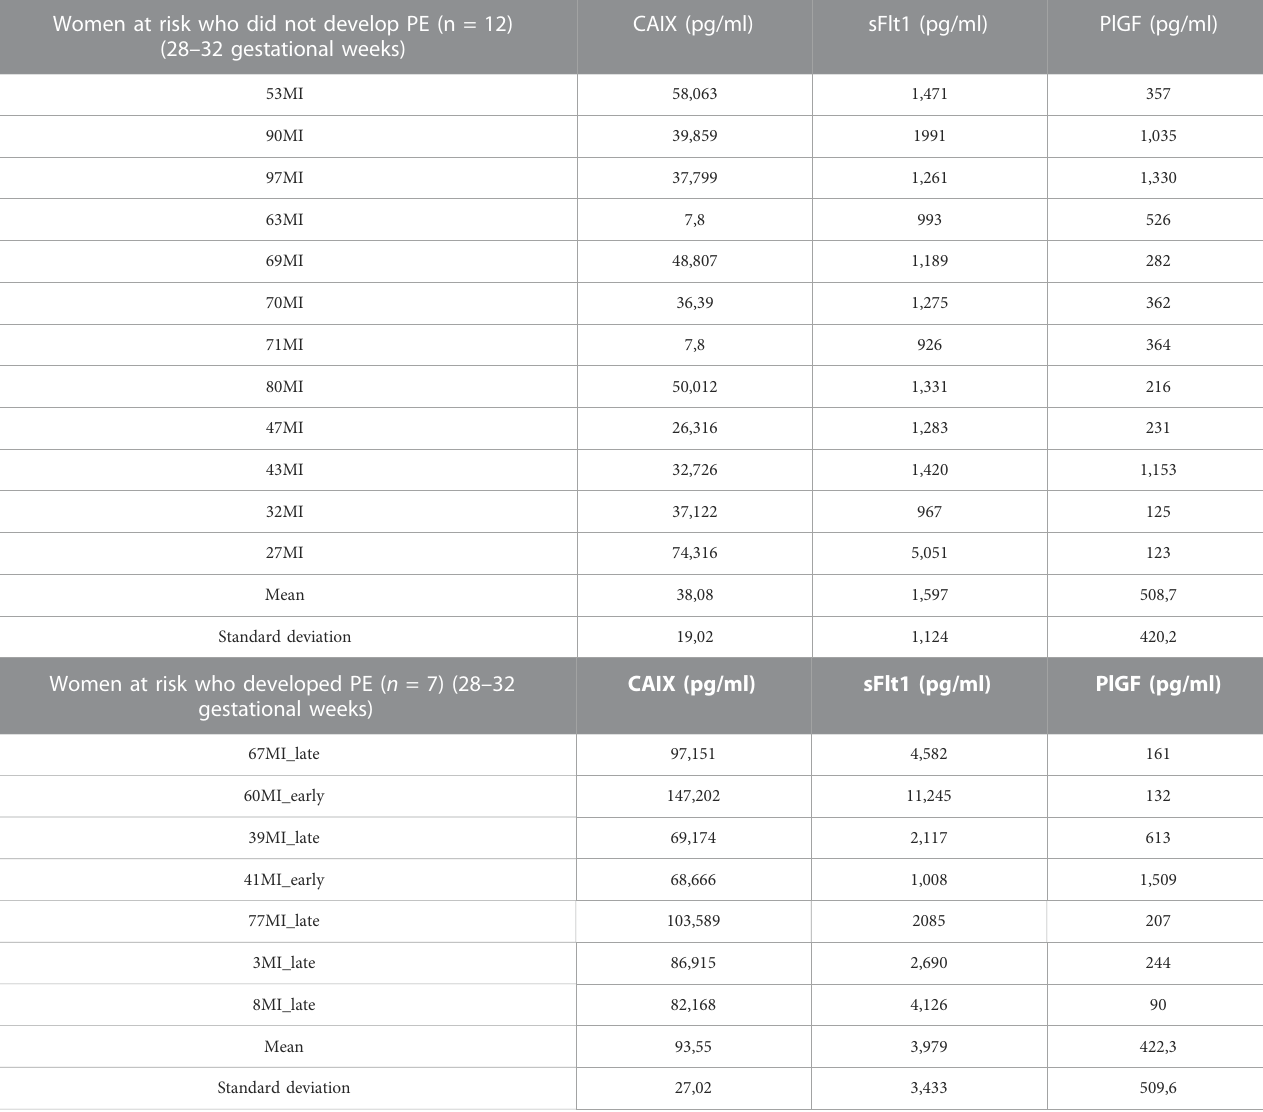
TABLE 2 Value of circulating CAIX, sFlt1, and PlGF for individual women. Women at risk who did not develop PE (n = 12) (28 – 32 gestational